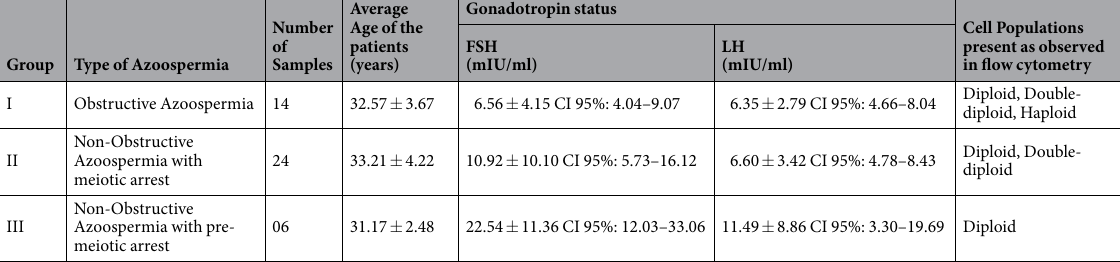
Table 1. Characterization of testicular tissues of azoospermic patients. Note: All values are shown as mean ± SD. FSH: Follicle Stimulating Hormone, LH: Luteinizing Hormone, mIU: milli-international units, CI: Confidence Intervals.